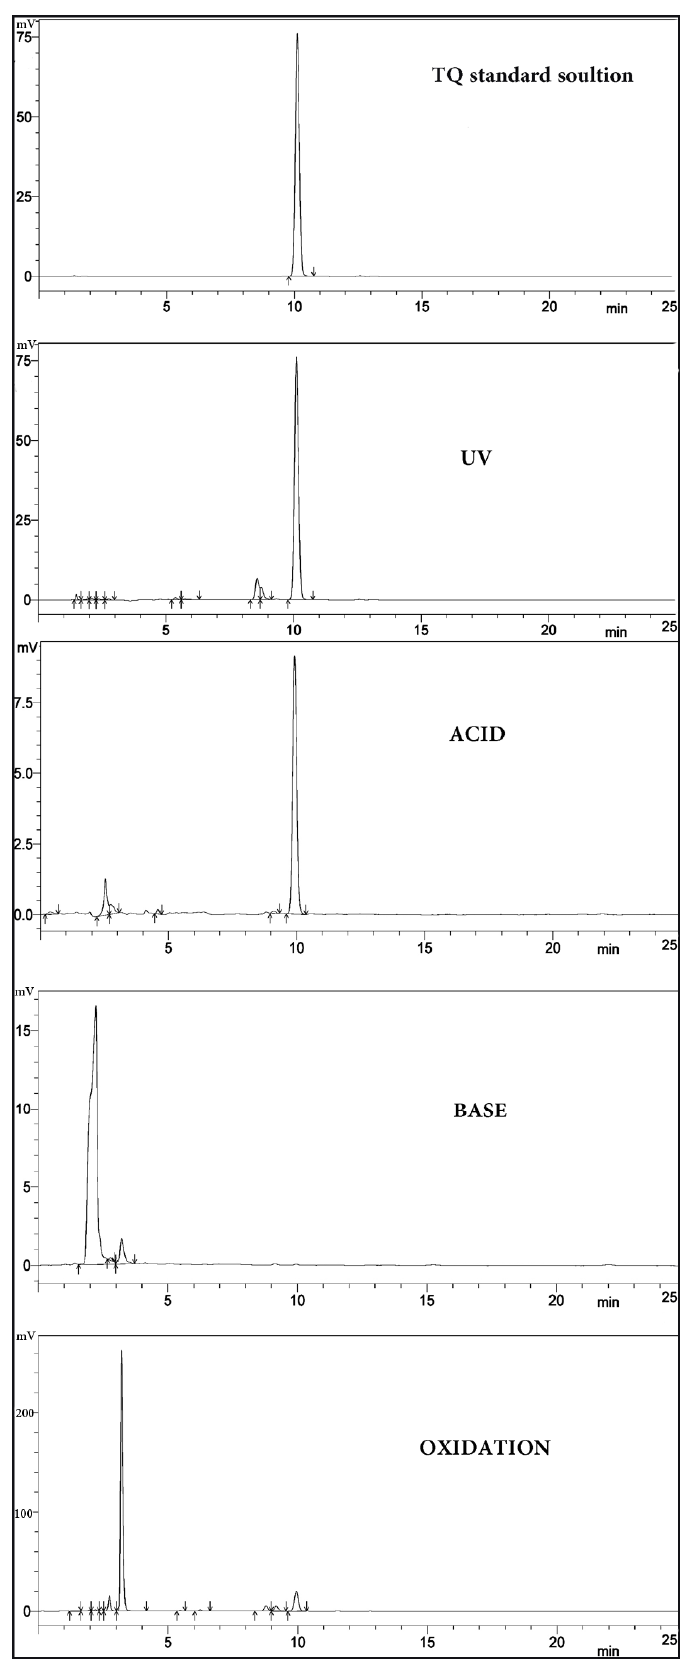
Figure 2. HPLC chromatograms of the forced degradation study of TQ in acid, base, UV, and oxidation stress conditions compared to the standard solution of TQ prepared in mobile